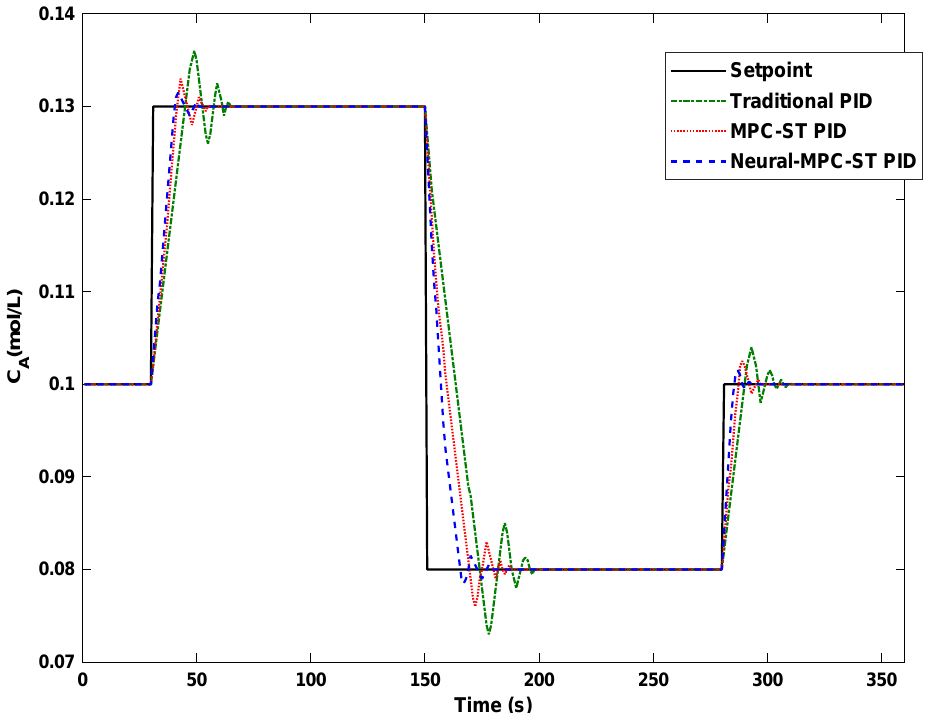
Figure 5. Comparison of suggested MPC Self Tuning PID method performance with traditional PID and MPC Self Tuning PID.